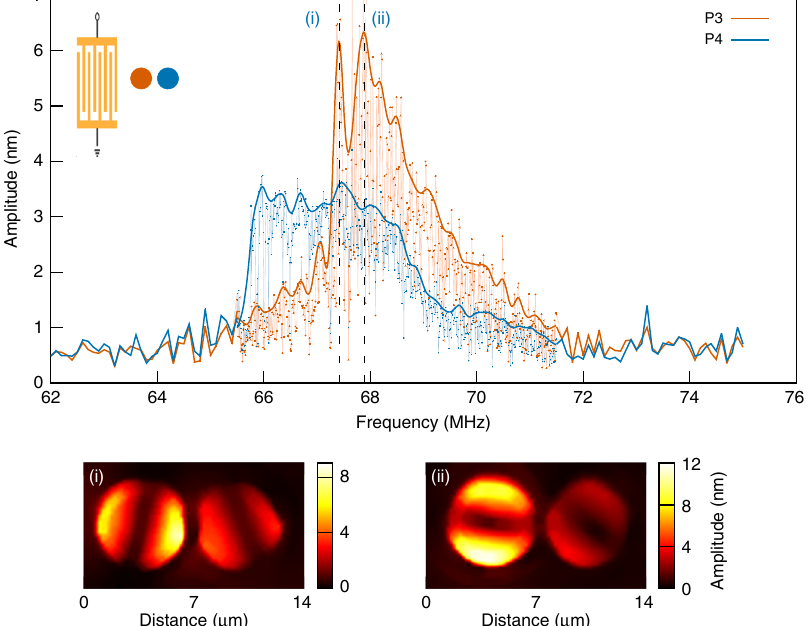
Fig. 3 Longitudinal excitation. Experimental frequency responses of the 1.5 µ m-spaced pillars of the pair in the longitudinal con fi guration. Bottom: experimental out-of-plane displacement fi eld maps for typical frequencies: 67.43 MHz (i) and 67.90MHz (ii). The scan area is 14 µ m × 8 µ m, with a step size of 200 nm measurements, the mode splitting being too weak for an direction is strongly in fl uenced by the incident SAW wave vector, unequivocal discrimination of the different modes. This allows the direction is not as pure as the one expected from numerical to observe that frequency labelled (i) corresponds to a mode that simulations that quite naturally, and exclusively, predict a nodal behaves like a symmetrical dipole state, as shown by the phase line parallel to the impinging wavefront, regardless of the drive measurements reported in Supplementary Fig. 5. The measure- frequency. This may be accounted for by an increased surface- ments also show the existence of a second state, corresponding to mediated mechanical coupling favoured by the wave vector frequency label (ii), where the vibration direction of the two-pillar direction that would tend to increase the coupling strength, hence ensemble is rotated by π /2 compared with the lower frequency forcing the pillars toward orthogonal polarisation states. The mode. These two modes are similar to modes (ii) and (iii) in the description of the coupled system therefore stands in between the case of the diagonal incidence. The direction of the excitation classical picture of inter-particle interaction and the usual theory source therefore rules out mode (i). Yet, if the pillar vibration NATURE COMMUNICATIONS| (2019) 10:4583